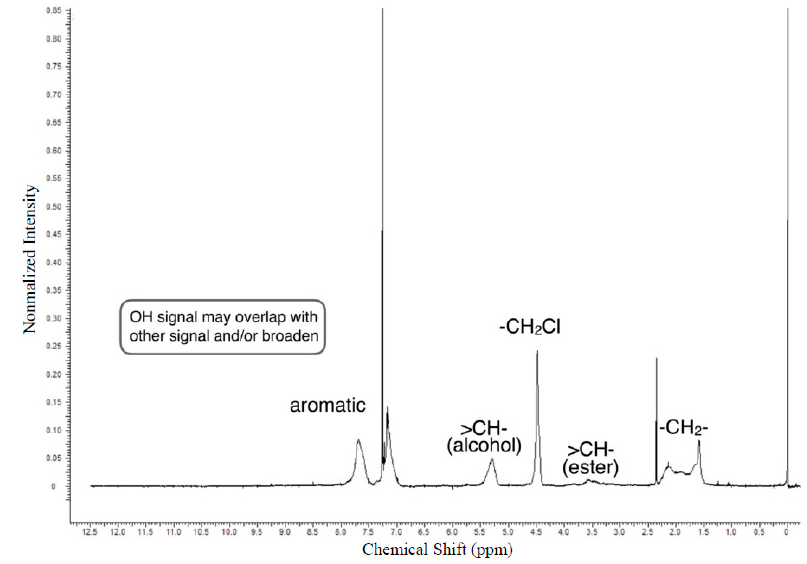
Figure 6. 1 H NMR spectrum observed for the prepared polymer. Chloroform containing tetramethylsilane was used as a solvent.